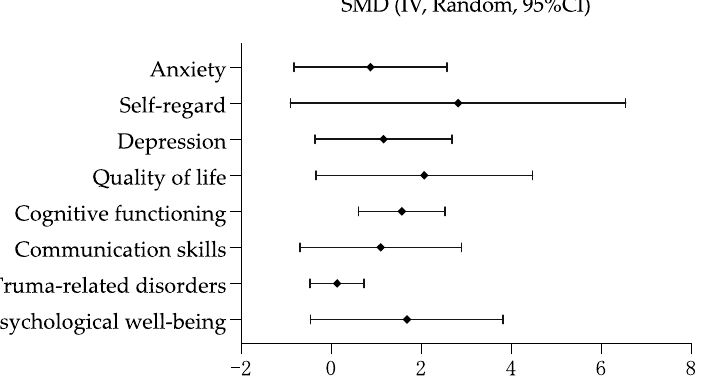
Figure 4. Overall effectiveness of drama-based intervention with controlled groups.